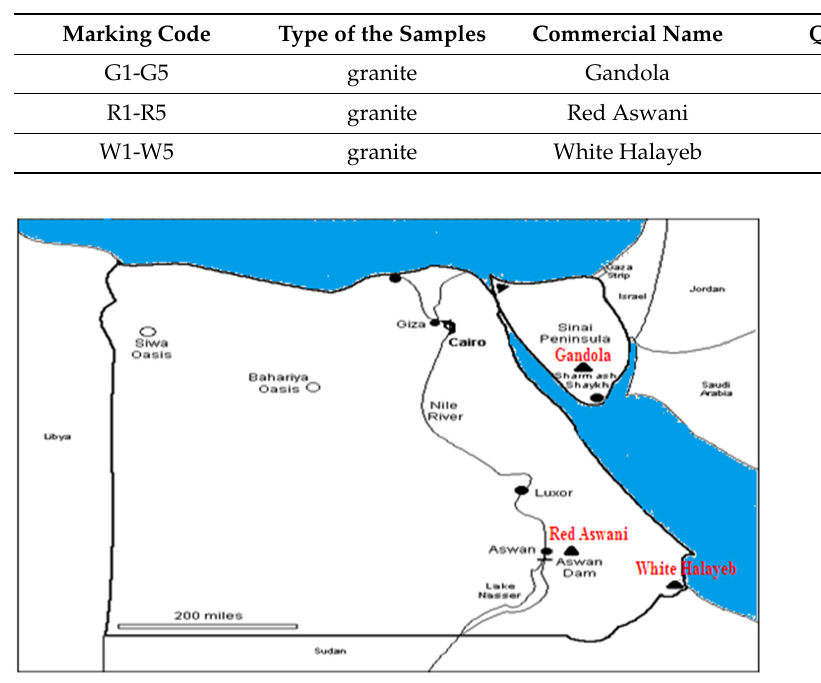
Figure 1. Map of the sample locations.